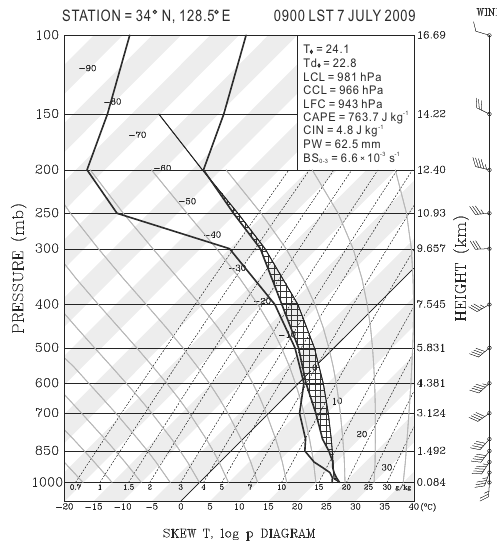
Figure 7. Skew T –log p plot of vertical profiles of tempera- ture, dew-point temperature, and horizontal wind (ms − 1 ) at 34 ◦ N, 128.5 ◦ E (cf. Fig. 5b for location) at 09:00LST 7 July 2009 in the simulation. The process curve for a surface air parcel is plotted. For winds, full (half) barbs denote 5(2.5ms − 1